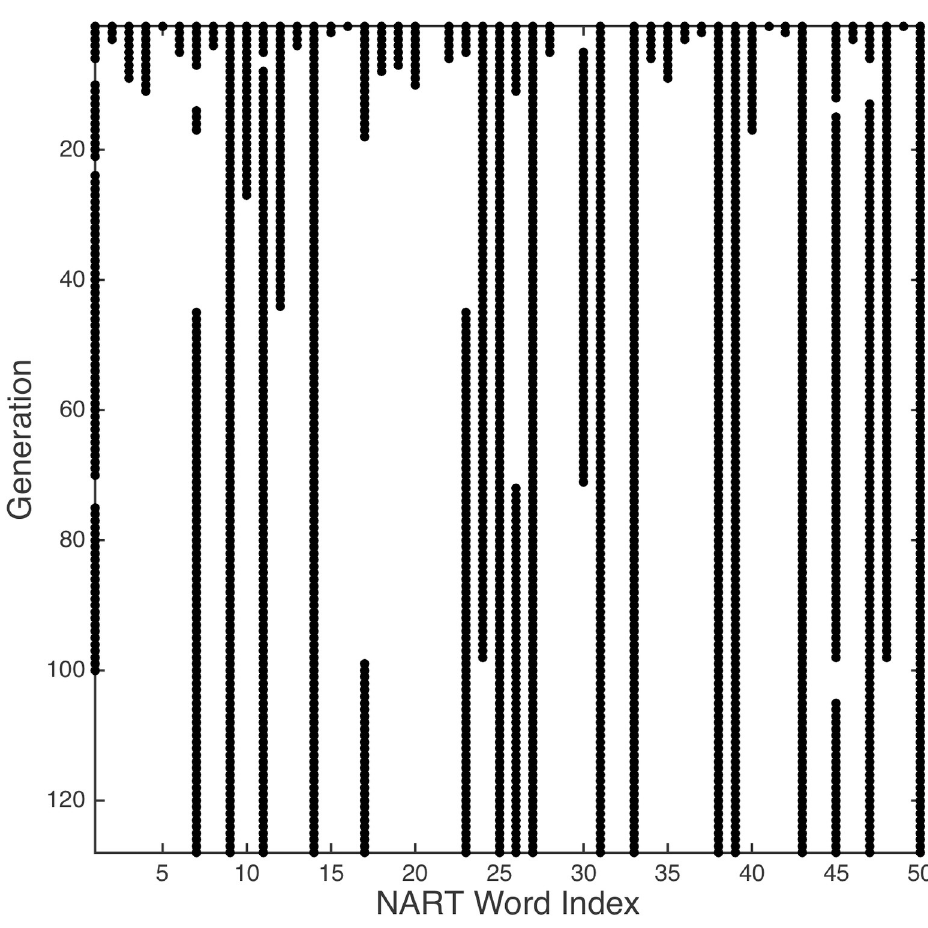
Fig 4. Chromosome evolution over 128 generations (top row is start point) in which black dots denote NART words used in the calculation of each participant’s revised NART score.